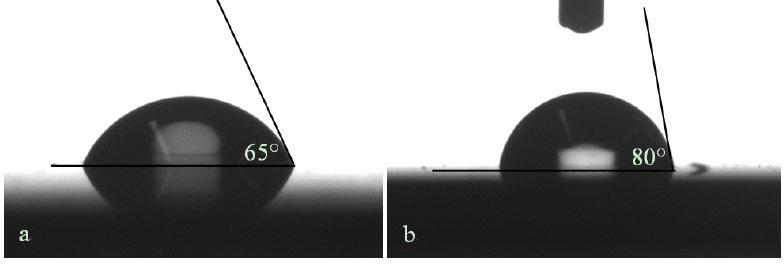
Figure 8. Water contact angle of the organosilica film ( a ) before and ( b ) after